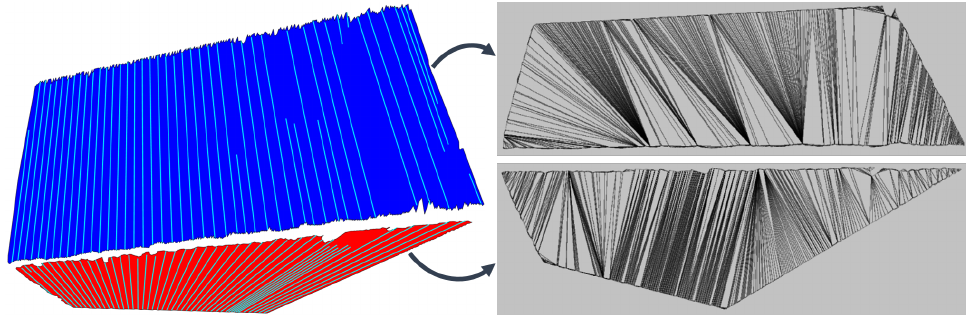
Figure 19. Bounded flat surfaces of a point cloud ( left ), whose boundaries are determined by projected endpoints of line segments. Clusters are shown where every tenth corresponding line segment is drawn. Triangle meshes of surfaces are shown on the ( right